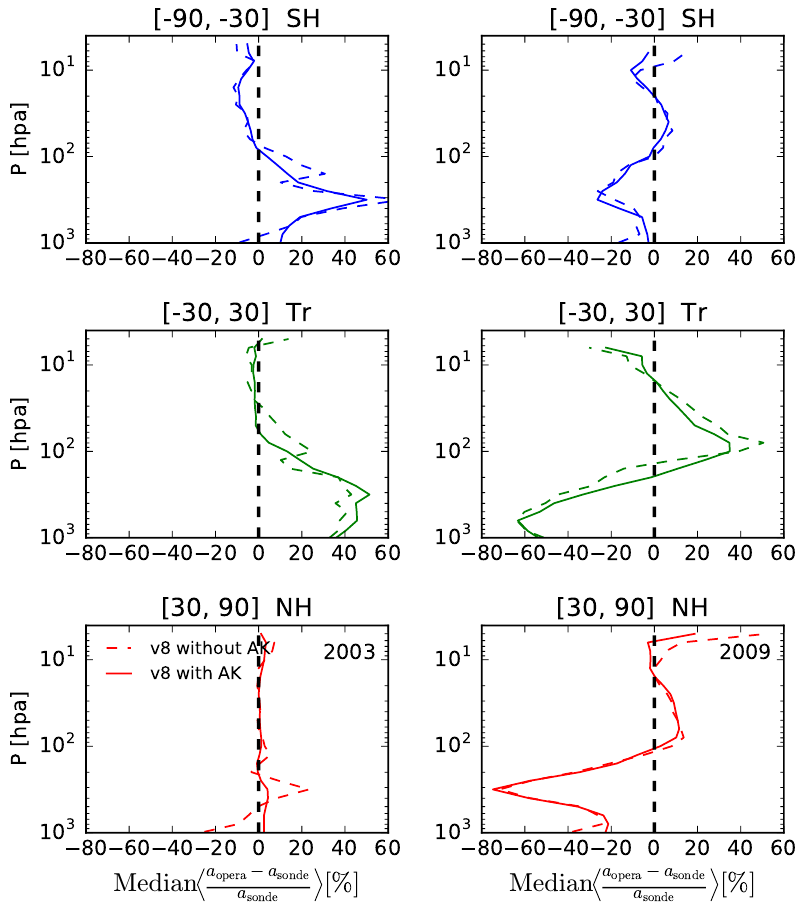
Figure 6. Comparison between SCIAMACHY retrieved ozone profiles and ozone sonde profiles with applying averaging kernels (AK, solid lines) and without applying averaging kernels (dashed lines). Here the L1 v8 data set is used for 2003 and 2009.